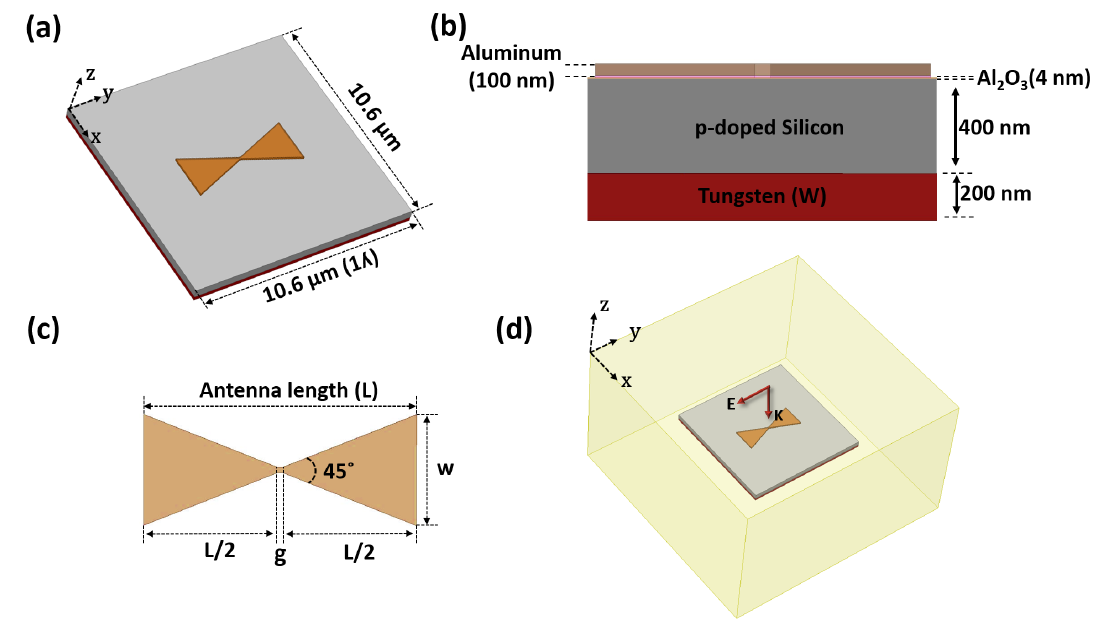
Figure 1. ( a ) The simulation model geometry of the nanoantenna-coupled p-doped MOS tunnel diode. ( b ) A cut-view of device geometry with layer thicknesses. ( c ) The detailed dimensions of the bowtie shaped nanoantenna. ( d ) The simulation environment inside a radiation boundary condition with a plane wave incident at 28.3 THz.